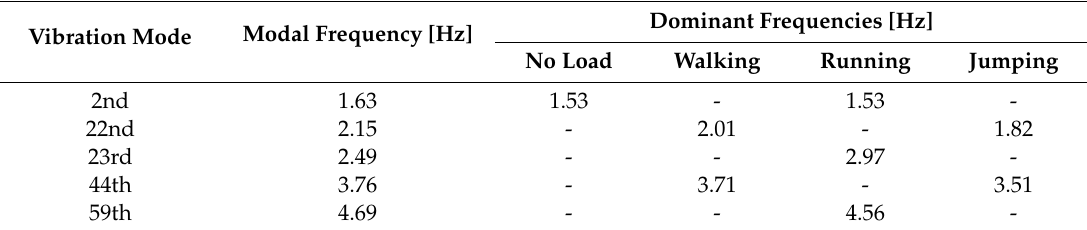
Table 2. Dominant frequencies of structural deformation identified by GB-radar.